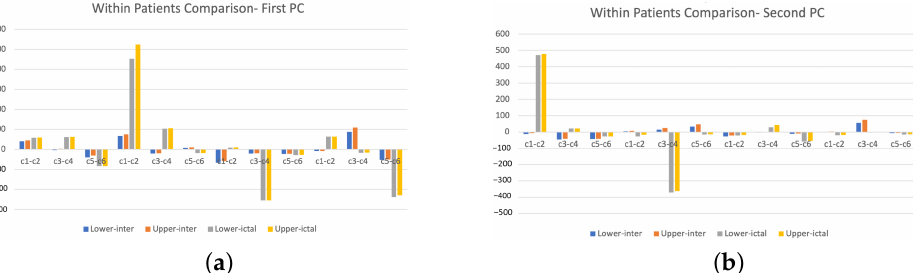
Figure 11. The plots of lower and upper 95% confidence limits of extracted first and second principal component scores of DWT power spectra for combined channels (i.e., c1–c2, c3–c4, and c5–c6) at both interitcal and ictal stages. ( a ) Interictal vs. Ictal, 1st PC, ( b ) Interictal vs. Ictal, 2nd